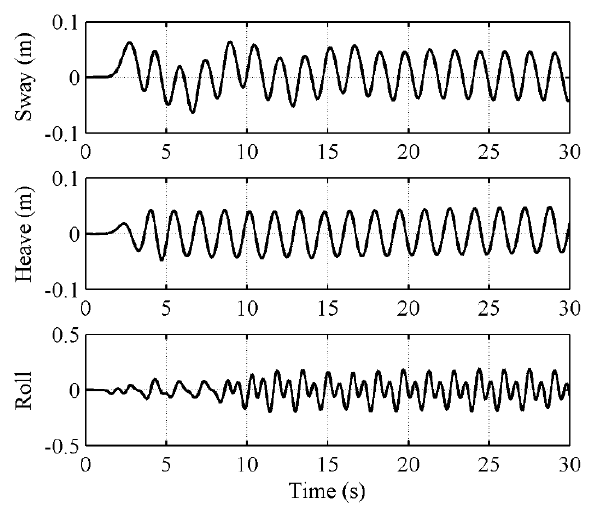
Figure 11. The time sequences of the motions of a moored floating box in waves.